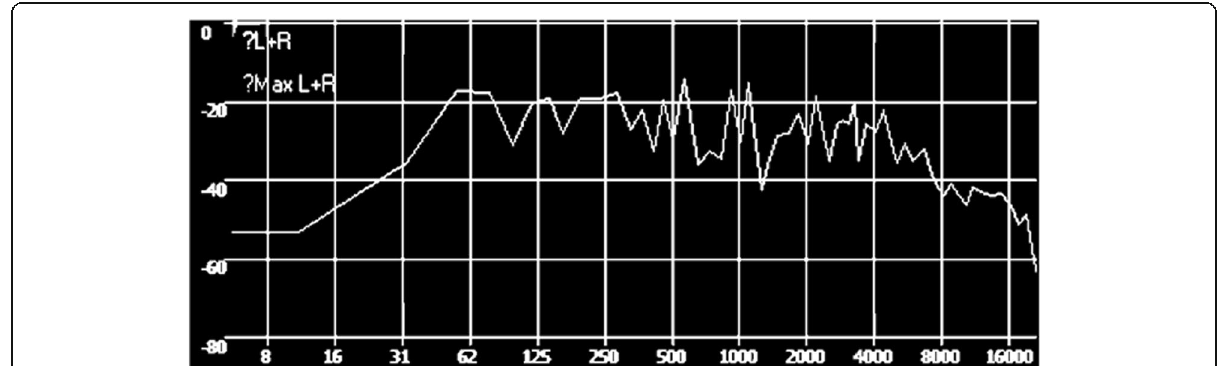
Fig. 6 The d sound image of small group two that Carava uses [a] vowel singing